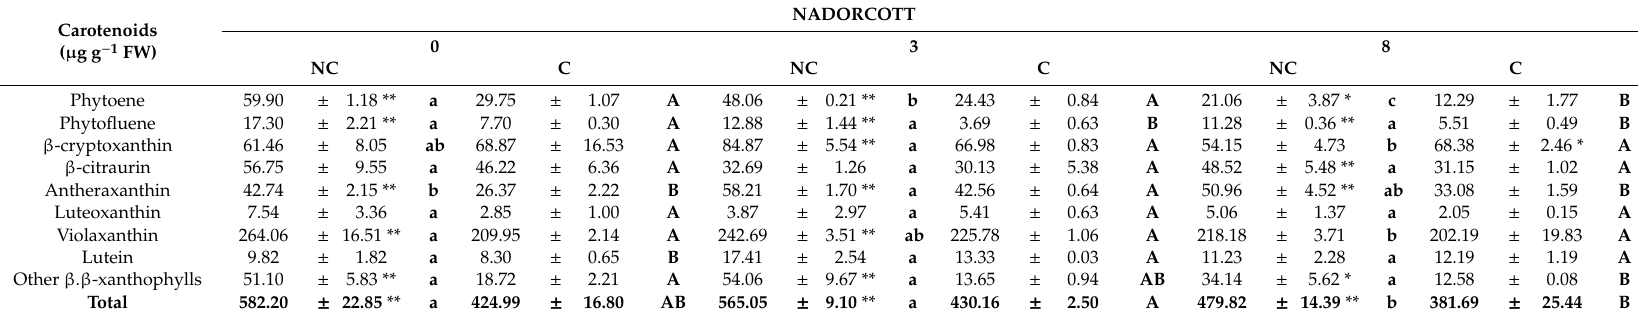
Table 3. Individual and total carotenoids ( µ g g − 1 FW) detected in the peel of non-covered (NC) and covered (C) fruit of Nadorcott mandarin at harvest (0) and after 3 and 8 weeks of storage at 2 ◦